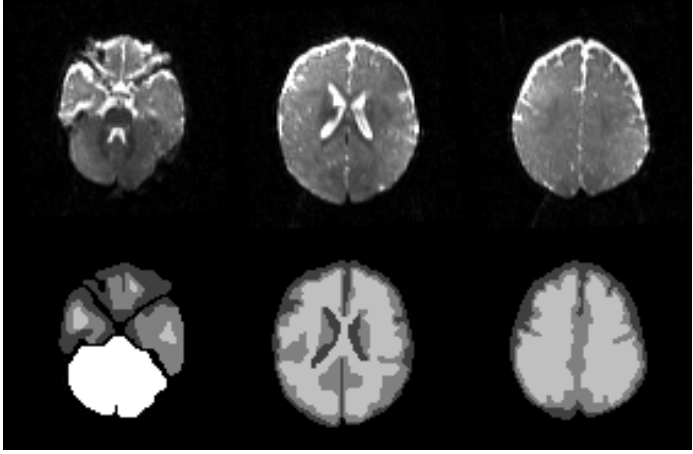
Figure 5. Example of the manual segmentation provided as a ground truth vs. the original b0 image slices, with each color (i.e., four colors) represent different labels (WM, GM, CSF, and